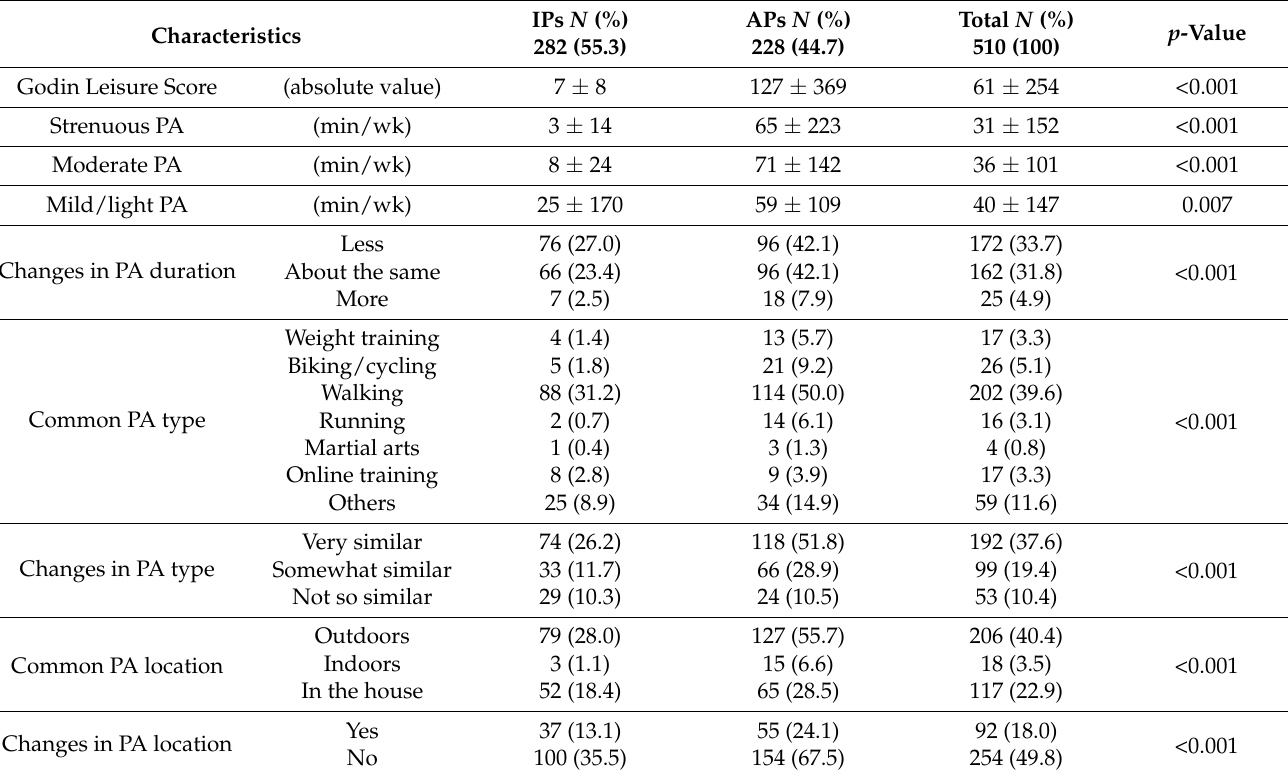
Table 2. Physical-activity (PA) behavior during Ramadan.